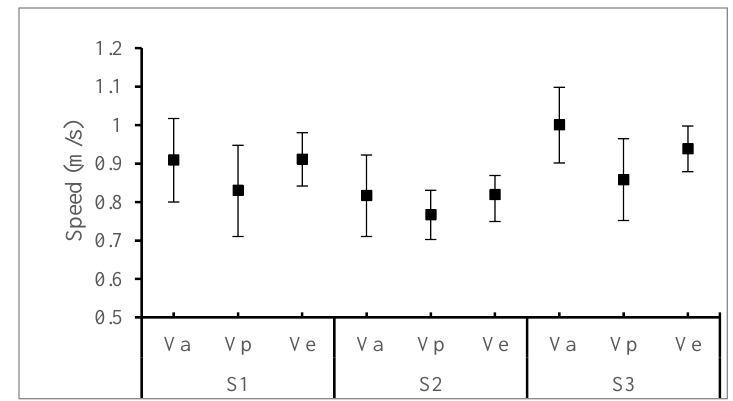
Figure 8. The mean speeds for all students walking through 12 steps for three ESs at three sites.